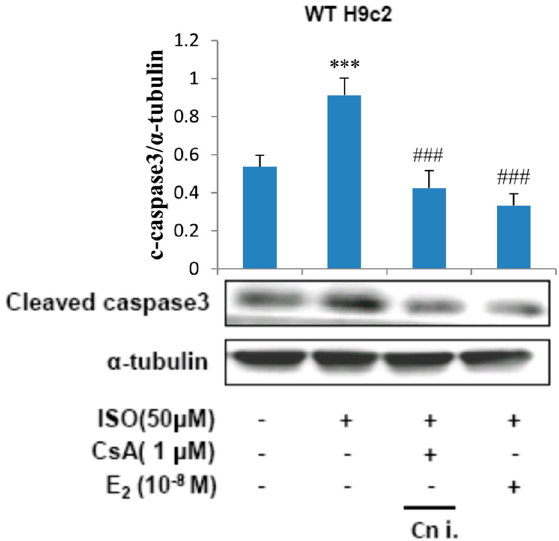
Figure 4. Calcineurin plays an important role in isoproterenol-induced cellular apoptosis signaling. H9c2 cells were incubated with E2 (10 − 8 M), CsA (1 μ M) in the presence of ISO (50 μ M) for 24 h, then western blotting was performed. Cleaved caspase3 and α -tubulin were detected by western blot. (*** = p < 0.001 indicates significant difference with respect to the control group; ### = p < 0.001 indicates significant difference with respect to the ISO challenged group).